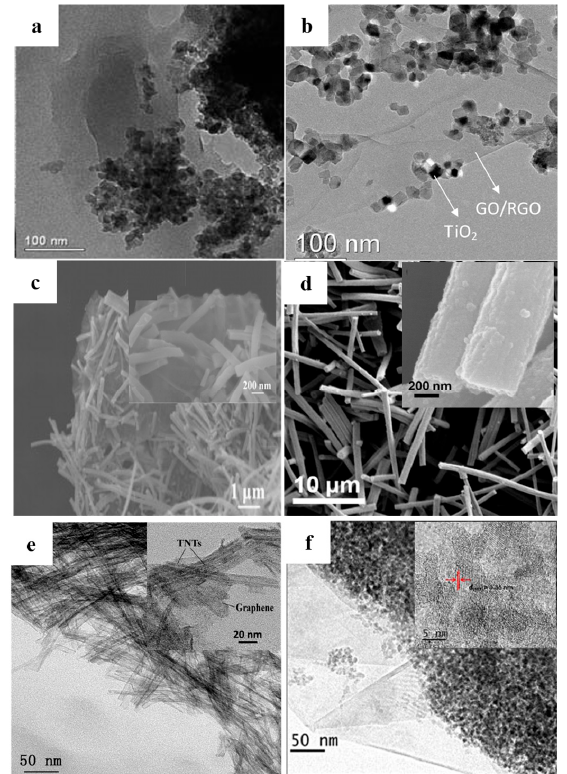
Figure 11. Graphene-TiO 2 composite photocatalysts with various morphologies of TiO 2 , ( a , b ) TiO 2